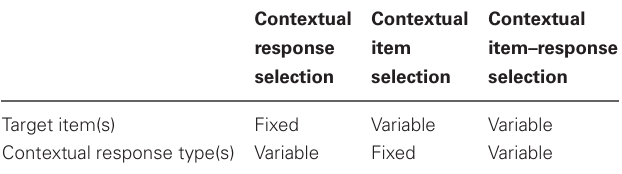
Table 1 | Categorization of contextual